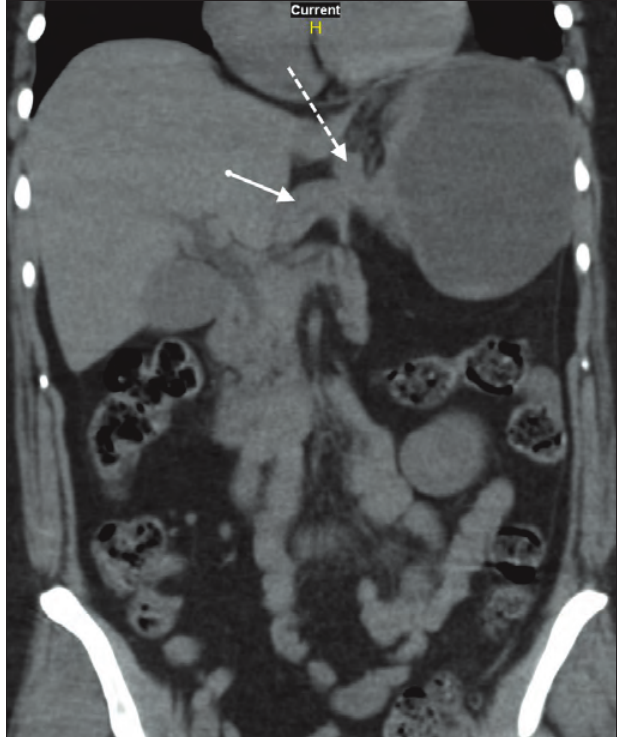
Fig. 5. Coronal CT image demonstrating the close relationship of the GO junction (broken arrow) and gastroduodenal junction secondary to the volvulus. The first part of the duodenum is shown by the solid